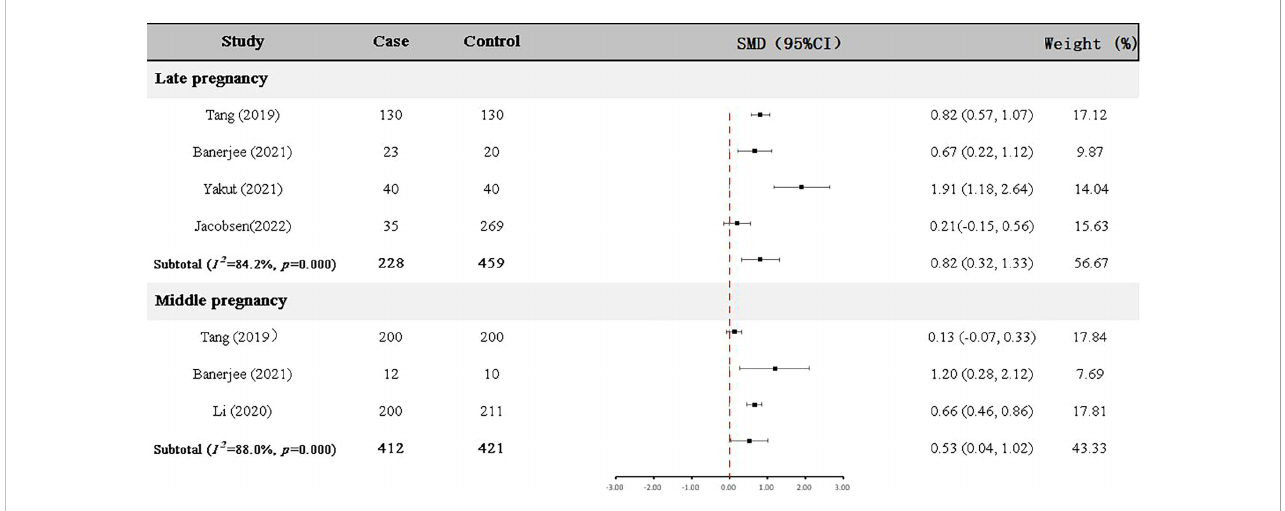
FIGURE 3 Difference of GDF-15 protein expression between GDM patients and non-GDM pregnant